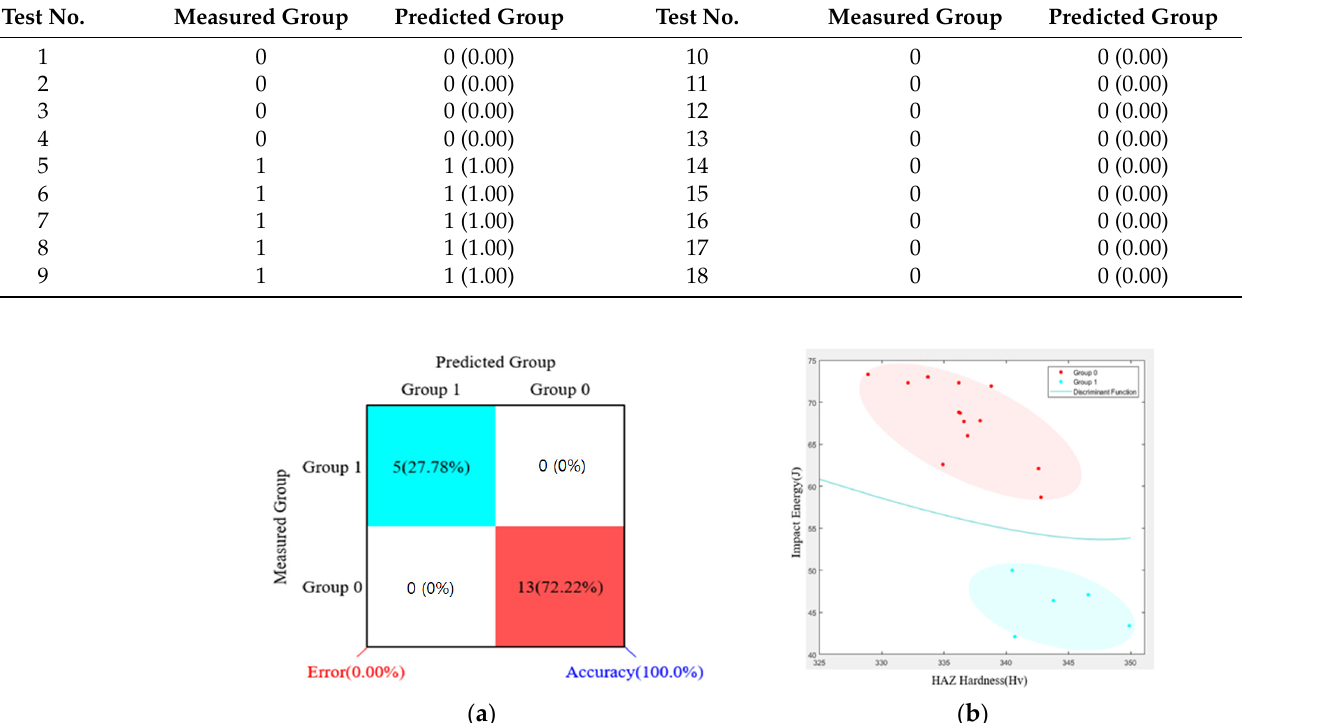
Table 11. Results of group discriminant for brittle fracture behavior according to SVM.